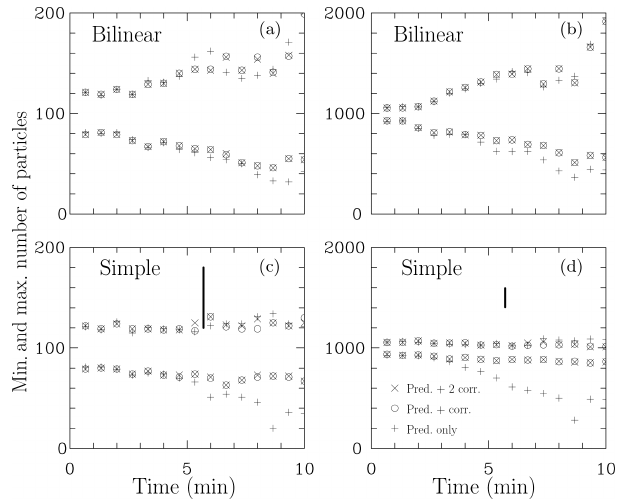
Figure 4. Evolution of the maximum and the minimum number of passive particles per grid cell in the bulk thermal simulations ap- plying (a, b) the bilinear advection scheme and (c, d) the “simple” scheme (Fig. 3). Panels (a) and (c) show results applying 100 pas- sive particle per grid cell, and (b) and (d) show results with 1000 passive particles per grid cell. Both schemes apply either the pre- dictor step or the predictor–corrector with either one or two correc- tive iterations. The vertical bar length in (c) and (d) corresponds to six standard deviations of the expected number of particles per grid cell. See text for